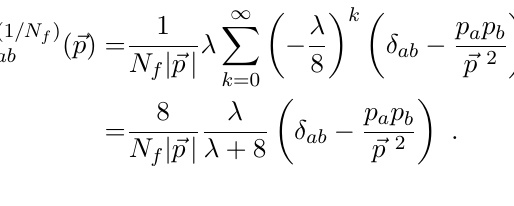
Figure 12 . The diagrams that contribute to the boundary propagator of the photon in the limit N f with (cid:21) = g 2 N f ! 1